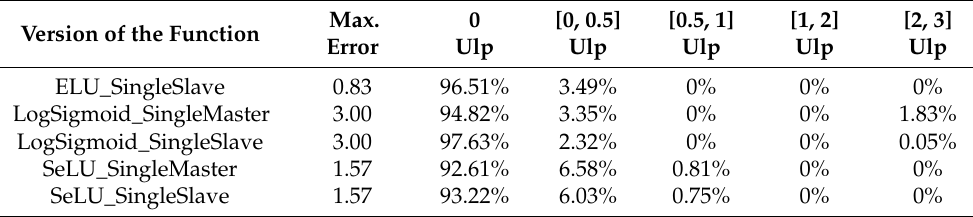
Table 6. Percentage of errors in each interval for functions with errors higher than 0.5